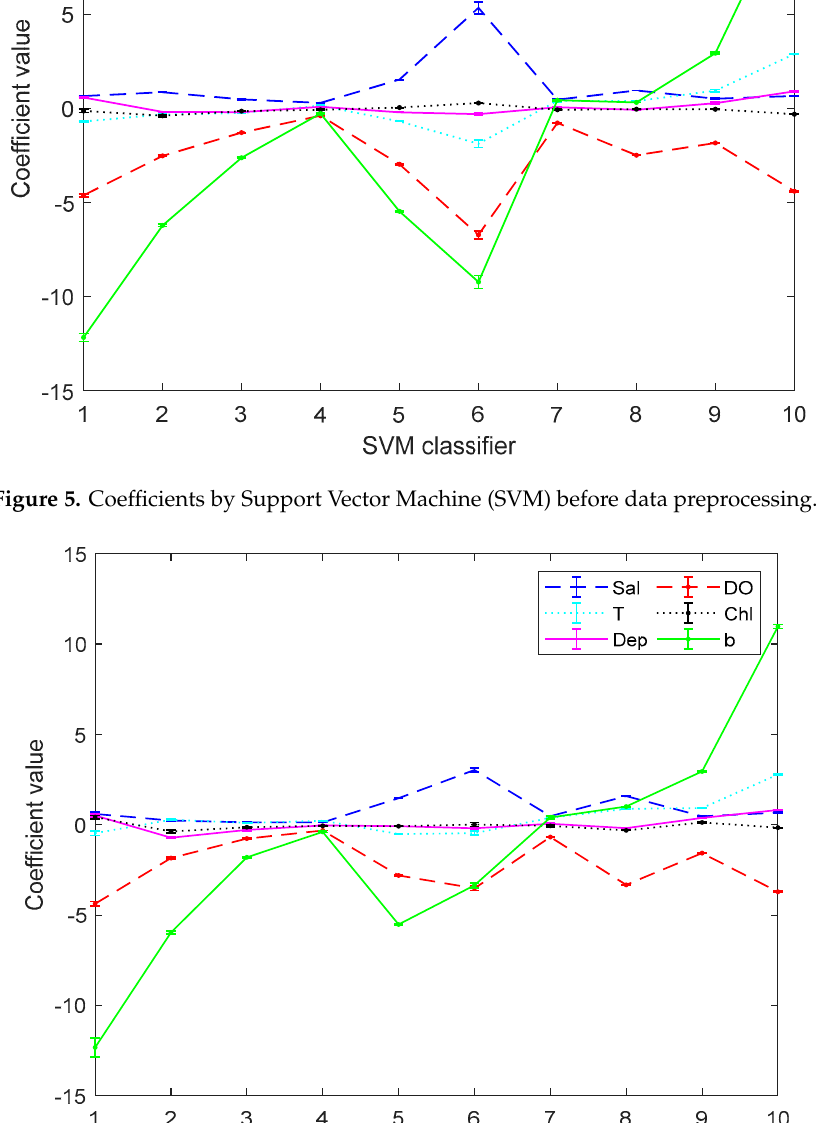
Figure 6. Coefficients by SVM after data preprocessing. Figure 6. Coe ffi cients by SVM after data